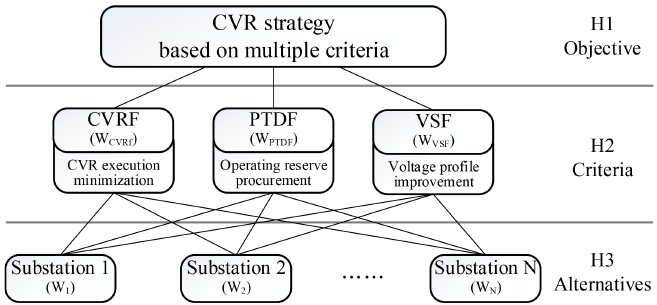
Figure 3. Hierarchy model of the proposed CVR